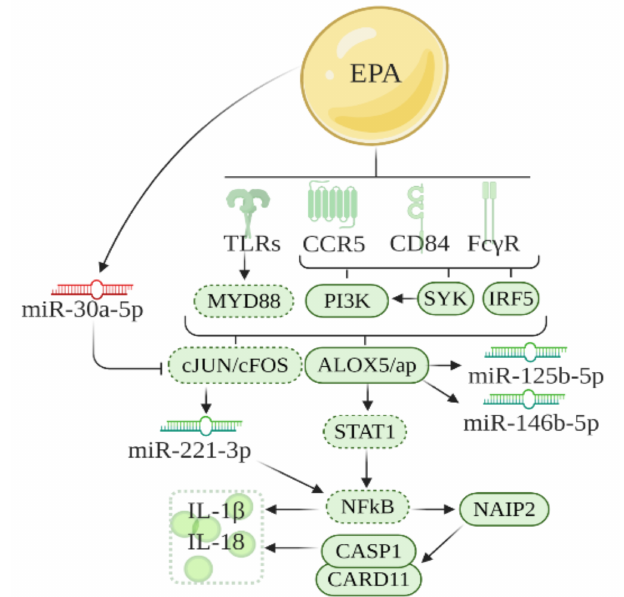
Figure 4. Schematic representation of the pathway regulated by EPA through modulation of genes and miRNAs in inflammatory pathways in VAT of obese B6 mice. The network is designed based on the IPA analysis and past literature. Solid lines around boxes, designed receptors, and miRNAs represent genes and miRNAs identified by our study, while dashed lines, represent genes from published literature. Red = upregulated; green =